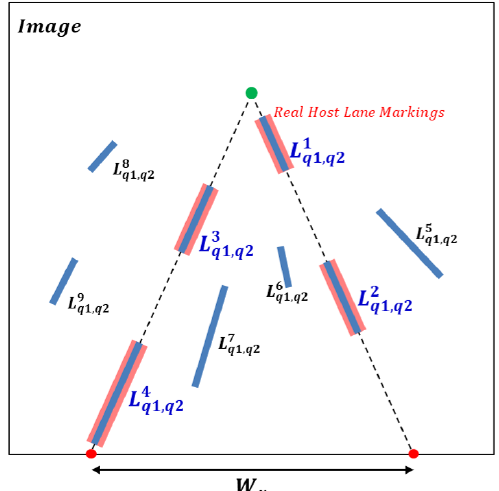
Figure 7. Example of lane-marking line segment score updating. Red rectangles are real broken host lane markings and constructed LaLis are represented as blue rectangles. The green point is the vanishing point of the host lane markings. Two cross points between the lower boundary of the image and extended host lane markings (dotted lines) are represented as red